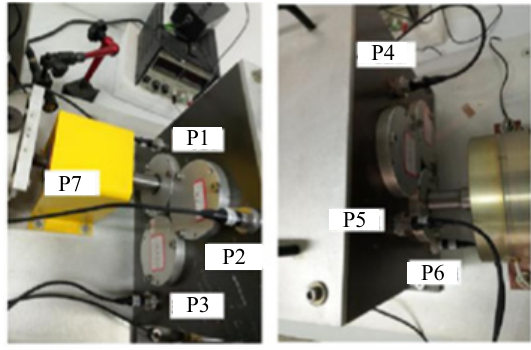
Figure 23. Location of sensor measuring points. Table 4. Test bearing’s specific parameters.